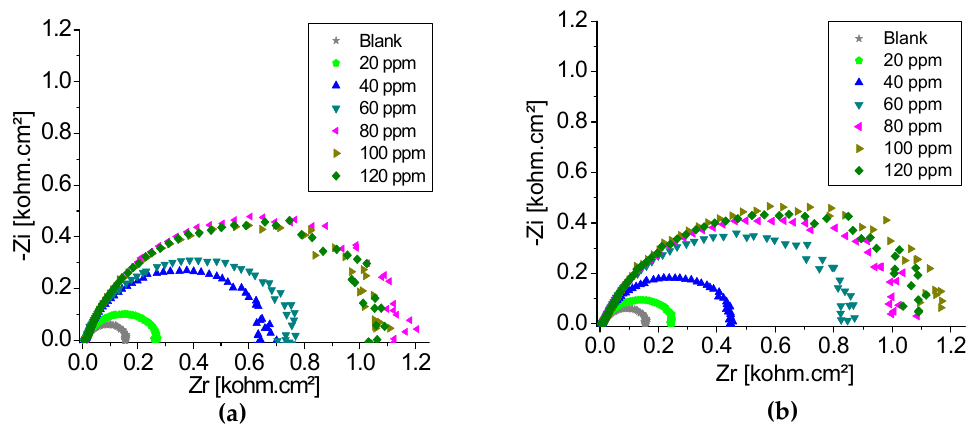
Figure 2. Nyquist Z curves of ( a ) IL1 and ( b ) IL2 at 25°C.